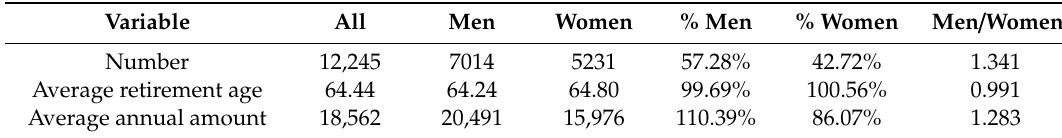
Table 2. Average data on new retirement pensions in